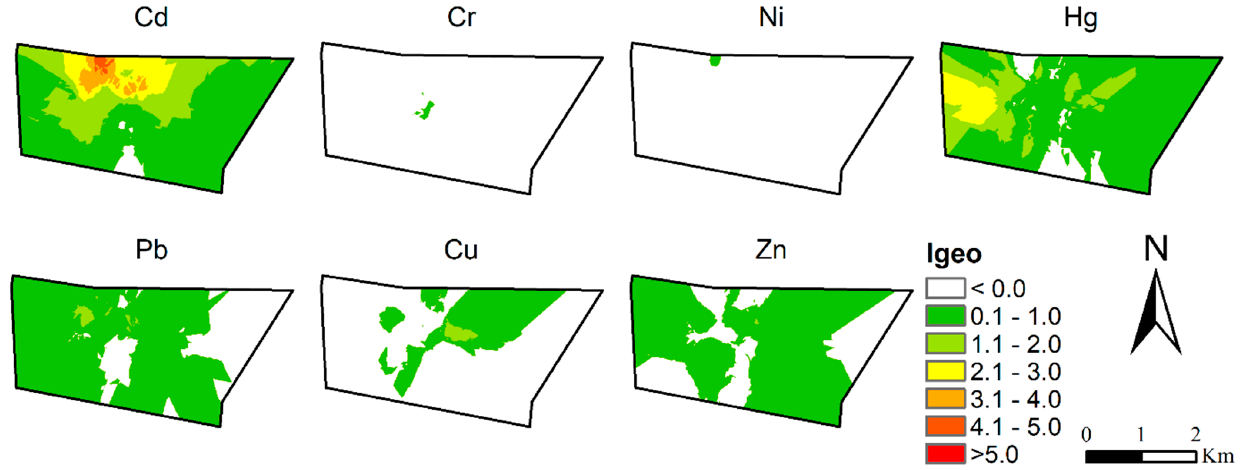
Figure 3. Classification map of heavy metal pollution using the index of geo-accumulation. (Elements without contamination were not displayed).